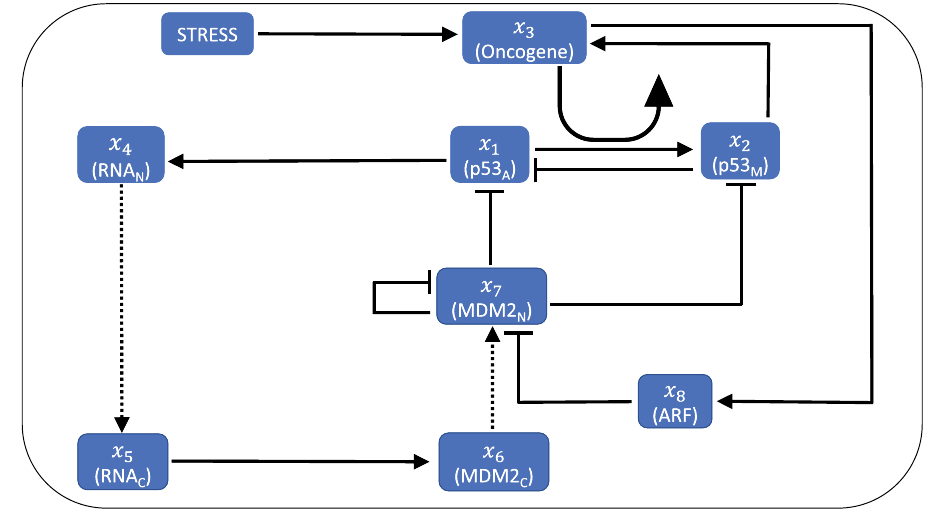
Figure 1. Interaction network for p53 A - p53 M -MDM2-ARF-Stress. Dashed arrow shows movement from nucleus to cytoplasm or vice versa, while solid arrow, and bars corresponds to activation, and inhibition on respective node. (Modified network from 35